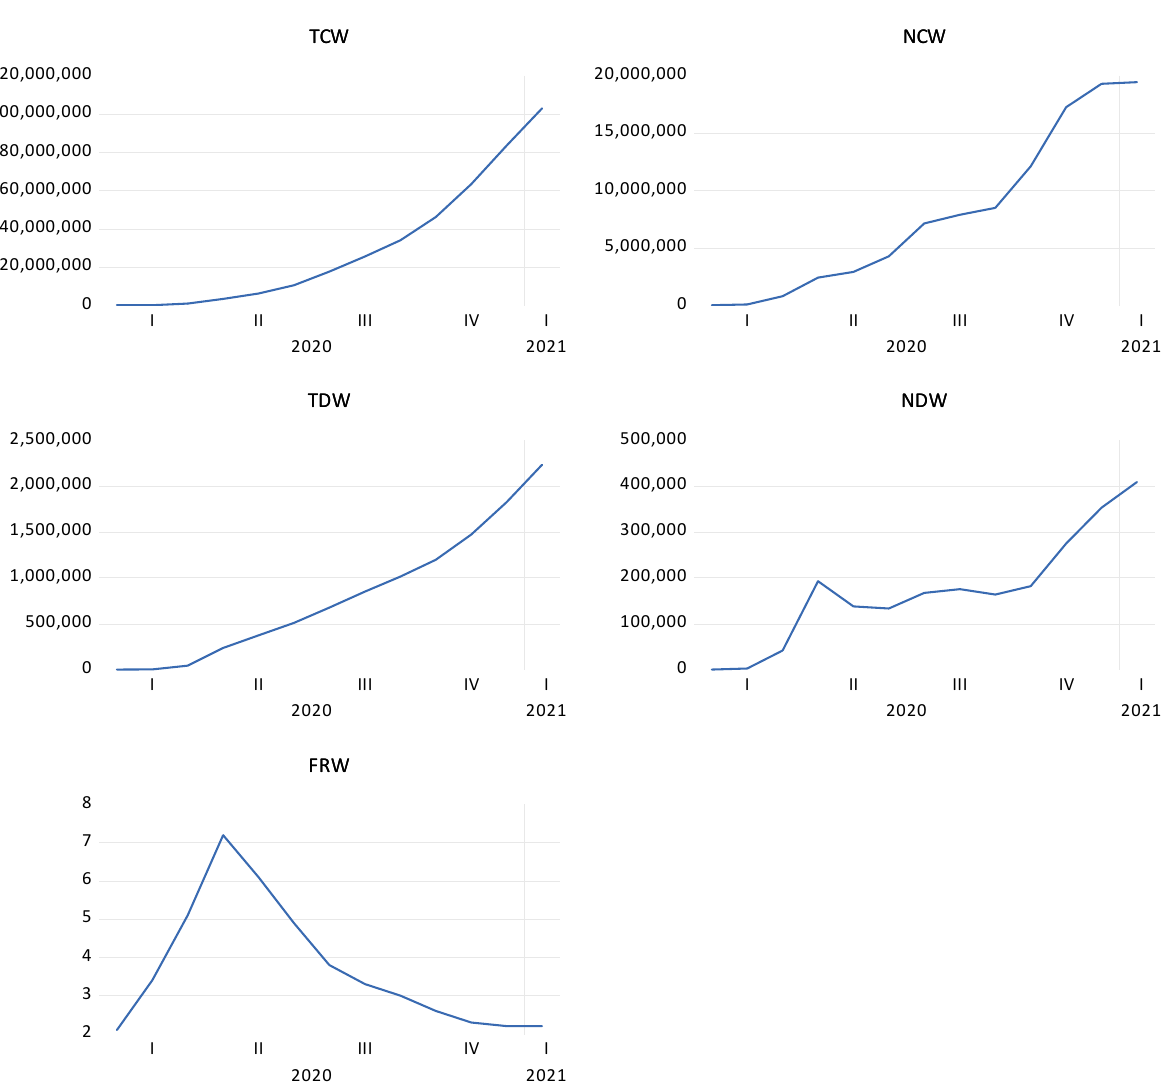
Figure A4. Source: compiled by the authors based on World Health Organization Coronavirus Disease 2019 (COVID-19) situation reports and the Our World in Data Coronavirus Pandemic (COVID-19) (Roser et al. 2020) database. Note: I = 1st quarter, II—2nd quarter, III—3rd quarter, IV—4th quarter. For TCWt, NCWt, TDWt, NDWt, and FRWt, see Table 1.